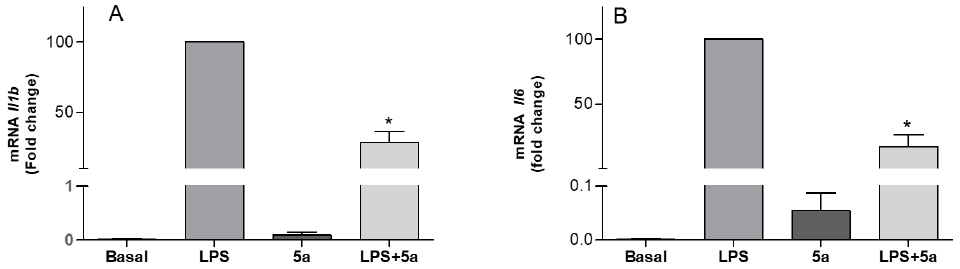
Figure 7. Inhibitory effect of compound 5a on mRNA pro-inflammatory cytokines expression. ( A ) Il1b and Actin-b mRNA levels in RAW 264.7 macrophage cells were determined by qRT-PCR and ( B ) Il6 and Actin-b mRNA levels in RAW 264.7 macrophage cells were determined by qRT-PCR. Results were expressed as a fold change relative to the LPS condition and mean ± SD (n ≥ 3 independent experiments performed in duplicate). Significant differences were determined by one-way ANOVA followed by Bonferroni t -test; * p ≤ 0.05 vs.